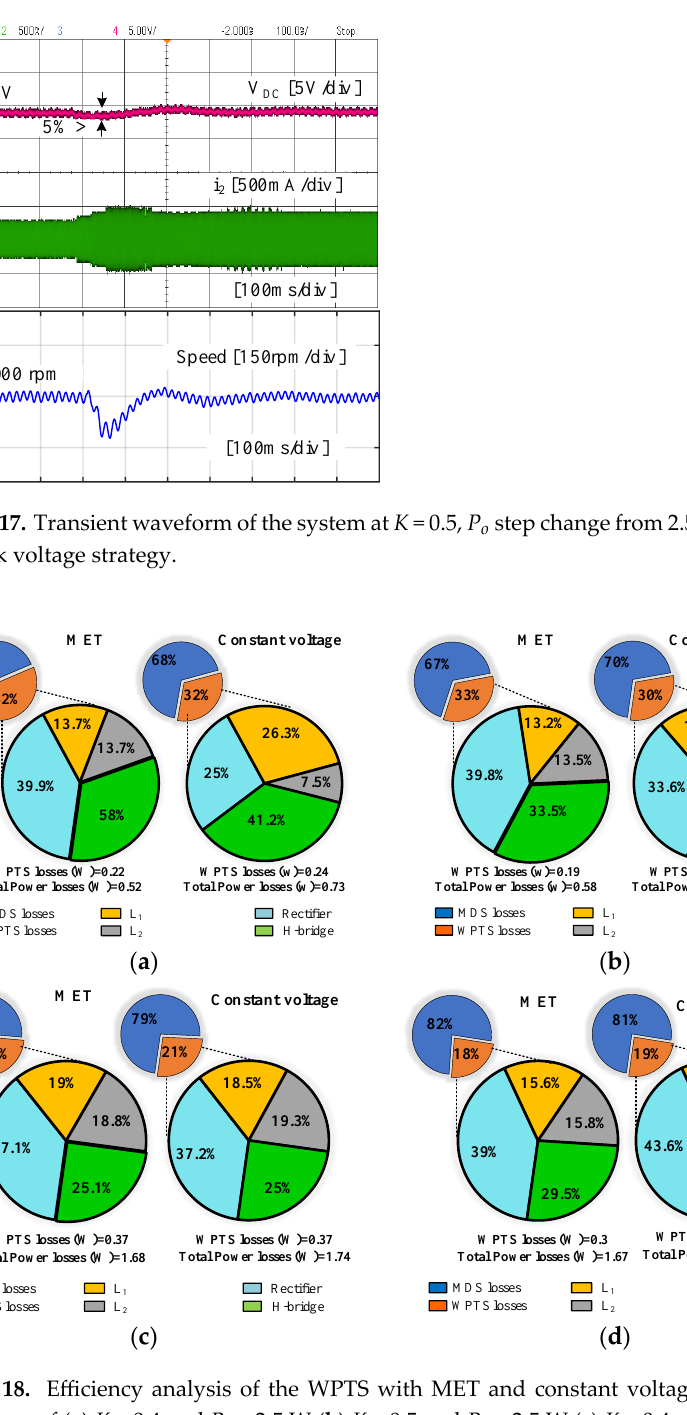
Figure 16. Transient waveform of the system at K = 0.4, P o step change from 2.5 W to 5 W for constant DC-link voltage strategy.